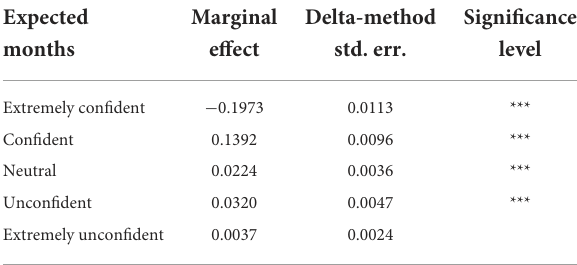
TABLE 9 Marginal effect analysis for confidence in controlling COVID-19 at the destination cities.